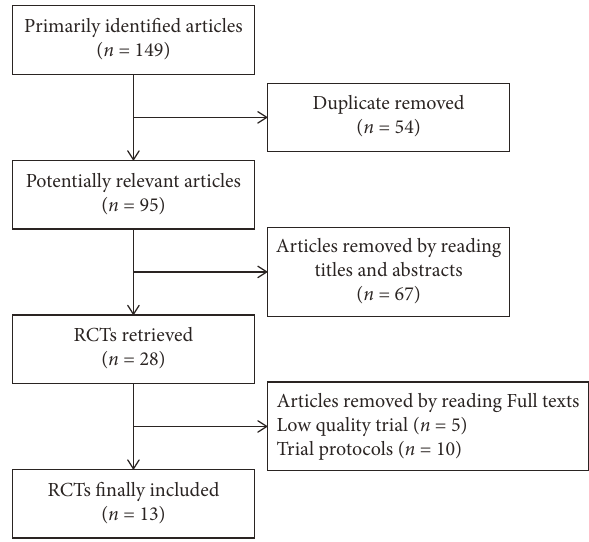
Figure 1: Flowchart of the process for selecting studies for the systematic